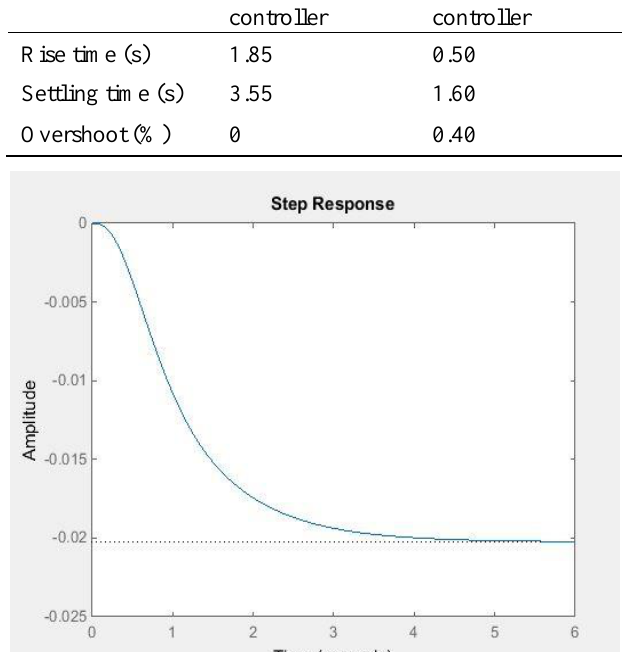
Fig. 14. Step response of Fuzzy Supervisory controller for Error and Change in Error (-100 to +100) Results of fuzzy supervisory